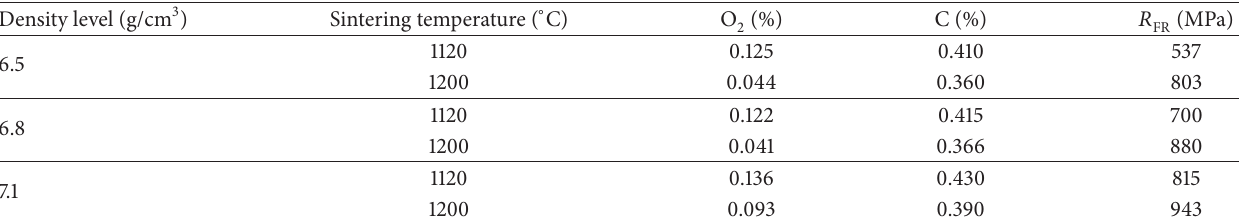
Table 7: Effect of sintering in N atmosphere on oxygen and carbon content in the AstCrM + 0.5% C at 1120 ∘ C and 1200 ∘ C for 30 min (with 2 heating rate of 10 ∘ C/min and cooling rates of 50 ∘ C/min) in relation to density.